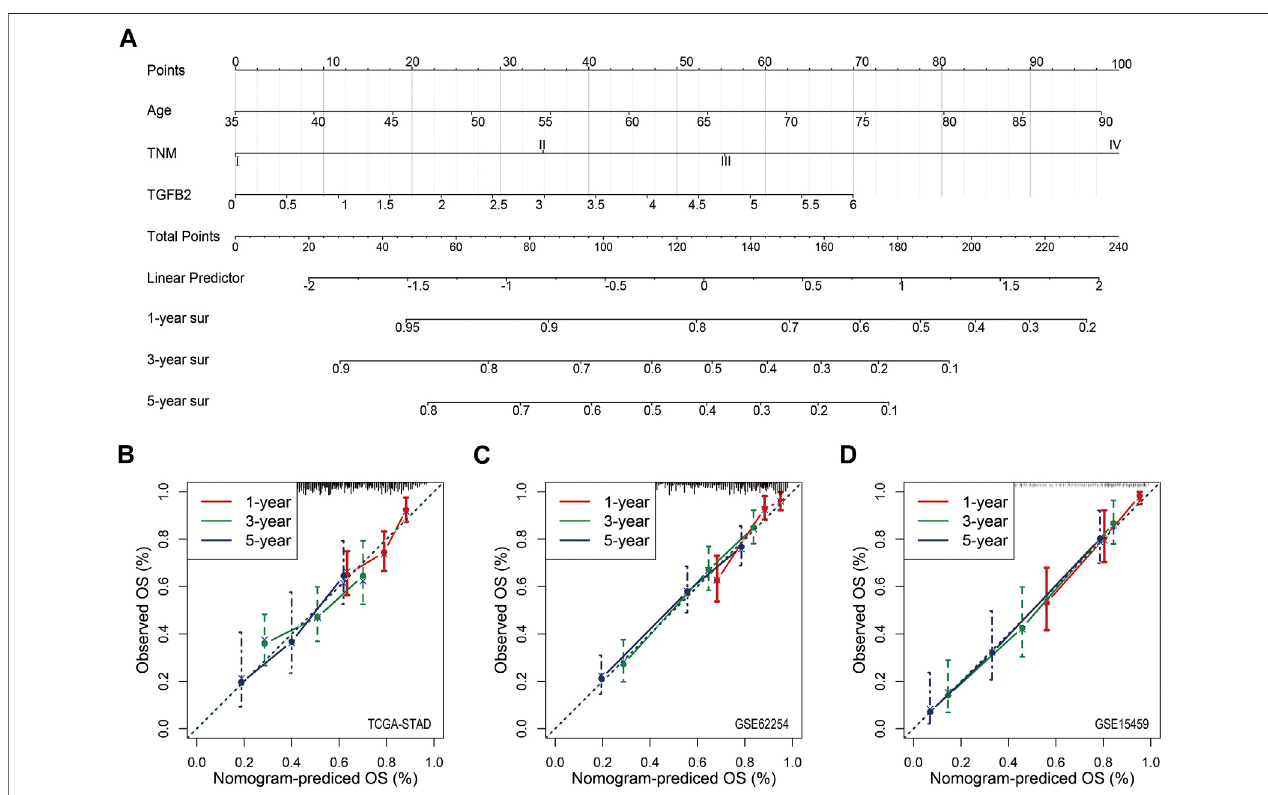
FIGURE 10 | Nomogram and Calibration. (A) Nomogram for predicting the probability of 1-, 3- and 5-years OS for STAD patients. Calibration curve for the nomogram for predicting the 1-, 3-, and 5-years OS probabilities for STAD (B) , GSE62254 (C) and GSE15459 (D) .